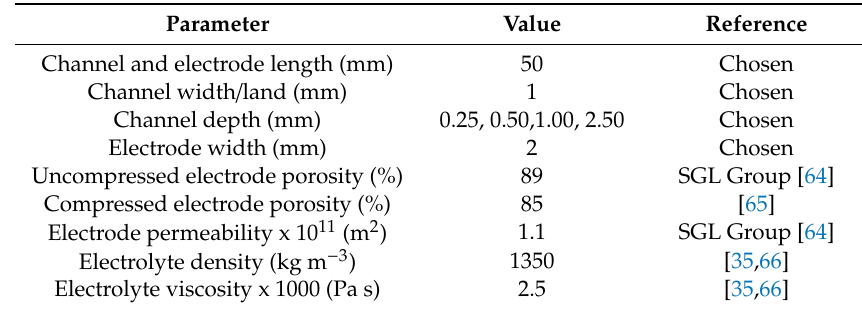
Figure 1. Simulation domains with channel and electrode [56]. Table 1. Simulation